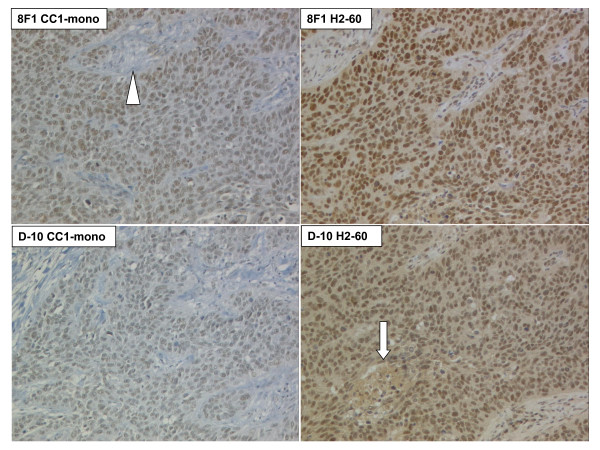
Anti-ERCC1 immunohistochemistry on whole sections of a lung squamous cell carcinoma, using Mab 8F1 and D-10 with CC1-mono and H2-60 protocols. Note increased cytosolic background with H2-60. Arrow: Necrotic centre. Arrowhead: Stromal axis. 100 × original magnification.